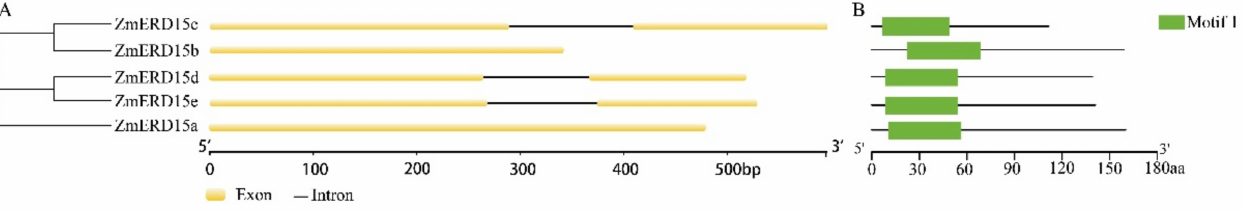
Figure 3. Gene structure ( A ) and motif composition ( B